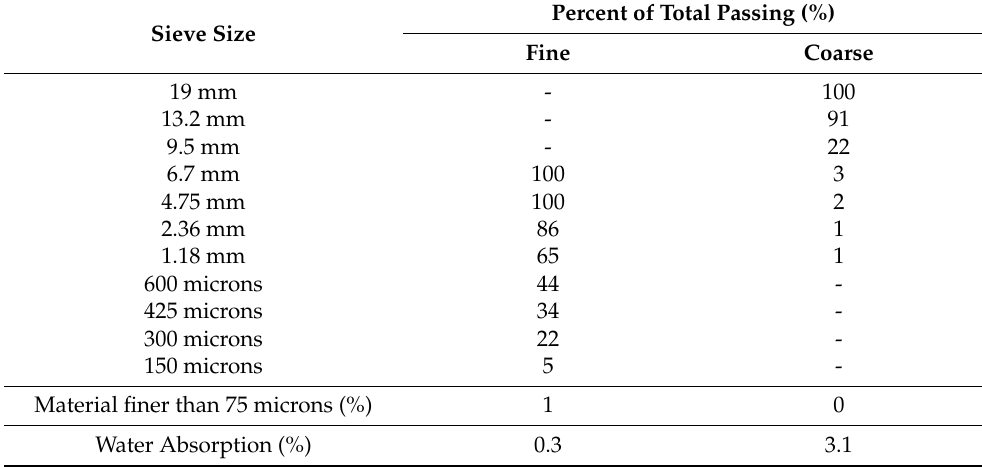
Table 1. Properties of the aggregates used.